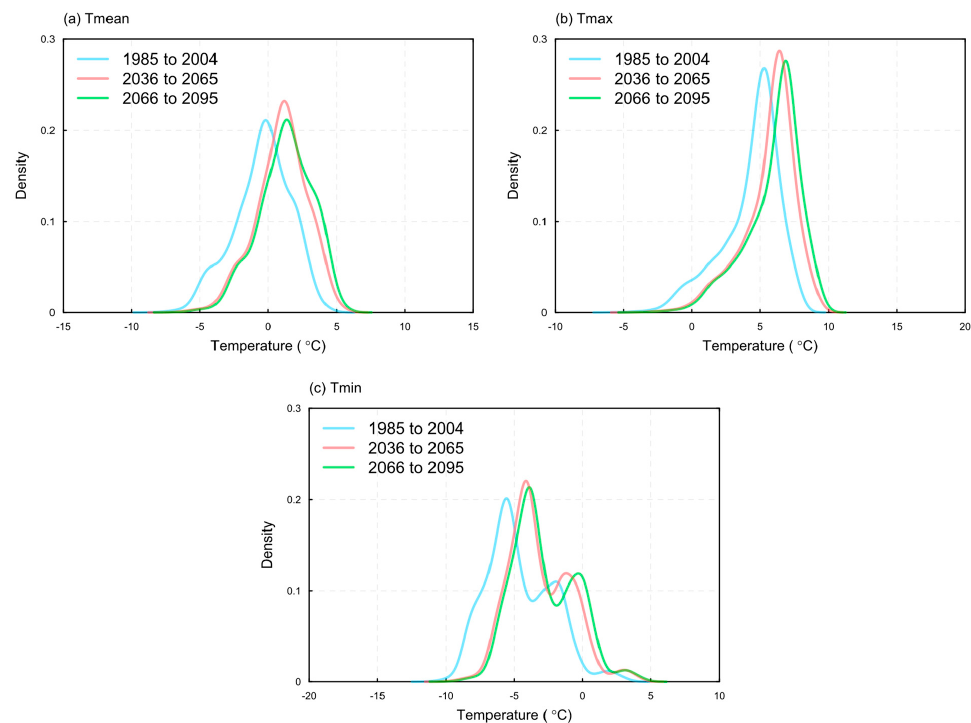
Figure 5. Spatial distribution of annual averages for the historical and future periods under RCP45. ( a ) T mean , ( b ) T max , and ( c ) T min .